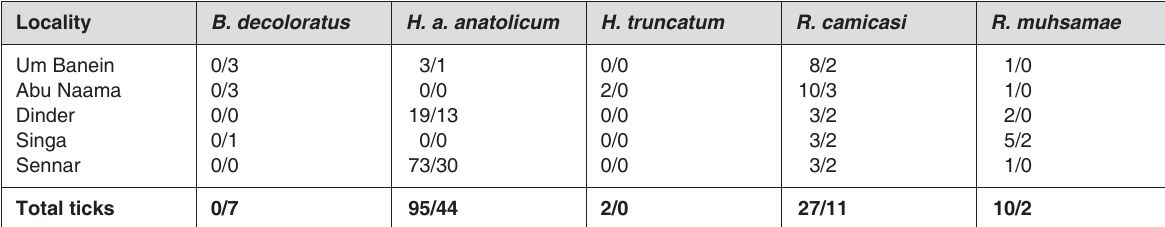
TABLE 5 Total numbers of ticks (male/female) infesting sheep in very low numbers at different localities in Sennar State in 2002/ 2003 Locality